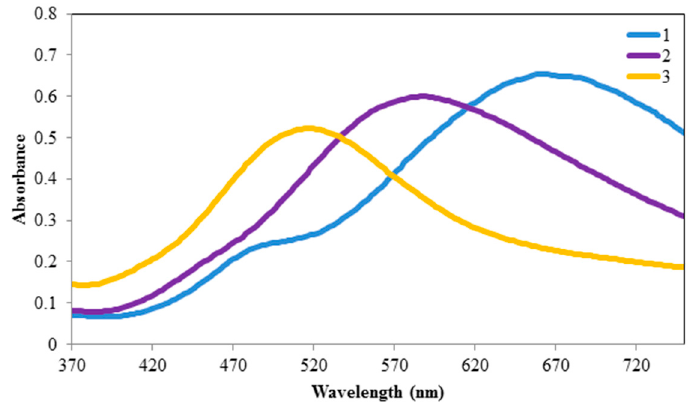
Figure 4. Absorbance spectra of the AgNPs in the absence (1, right) and presence of 2.5 µM (2, center) and 5 µM (3, left) HgCl 2 , after exposure for 30 min.